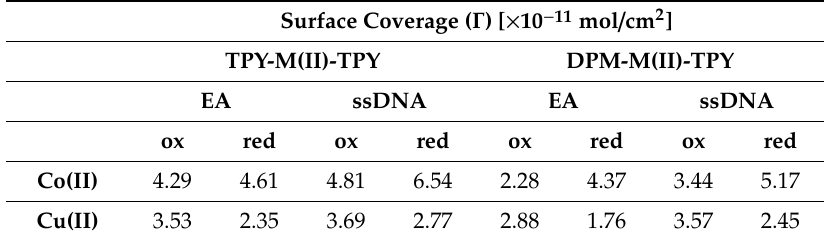
Table 4. The surface coverage Γ [mol / cm 2 ] of redox-active assembled on the Au electrode surface were calculated on the basis of relationships of cathodic and anodic currents vs. scan